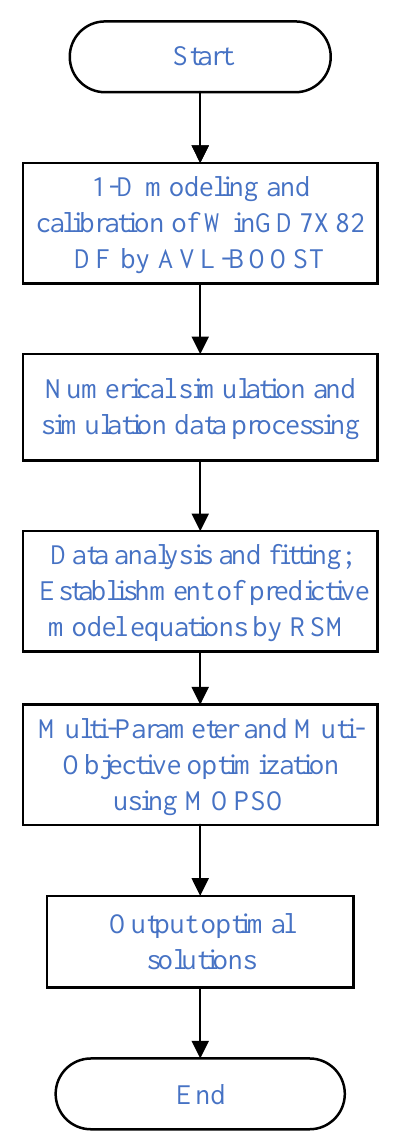
Figure 1. Flow chart of this article. Table 1. Dual-fuel engine’s main